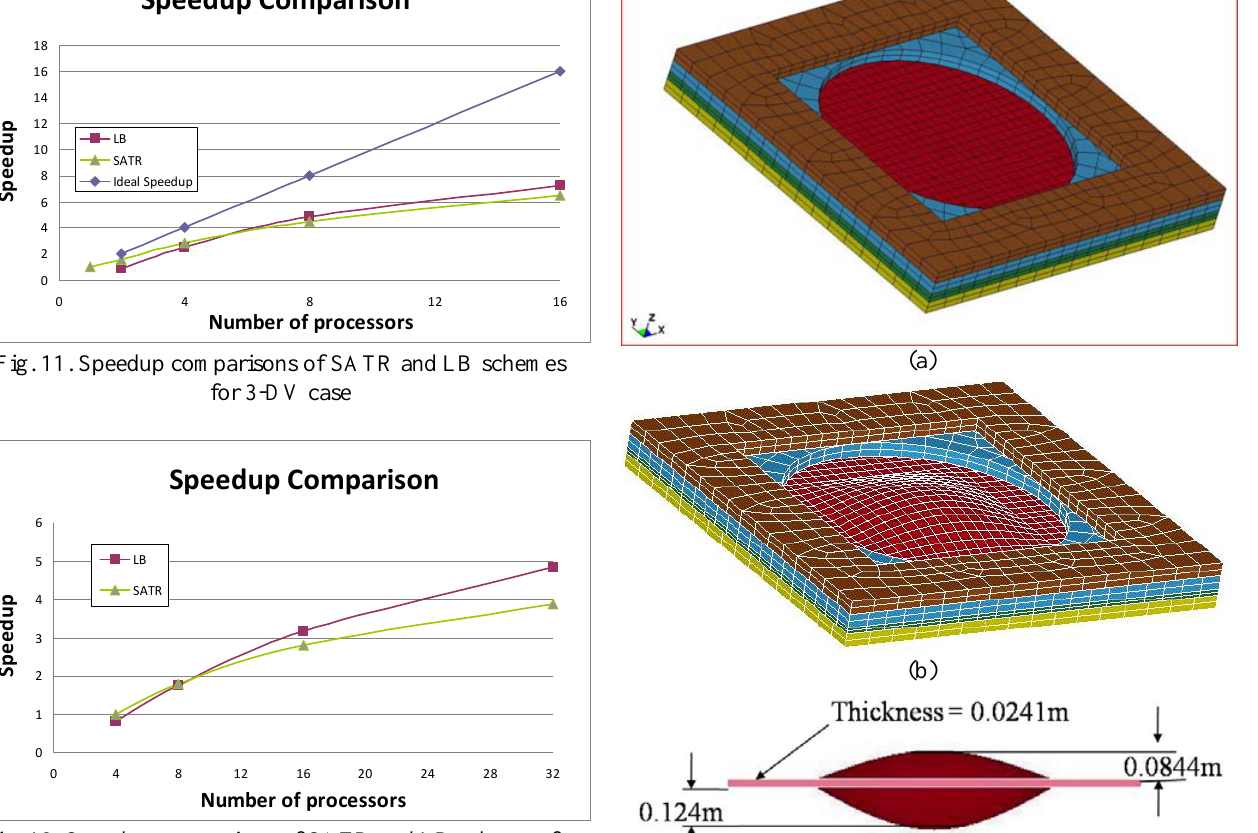
Fig. 12. Speedup comparison of SATR and LB schemes for 9-DV case